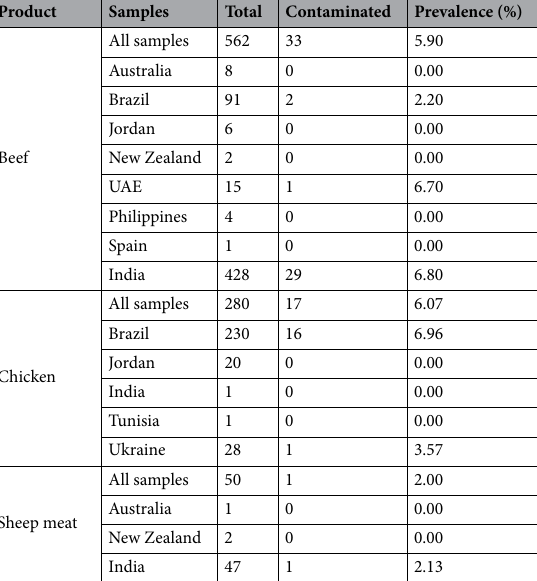
Table 1. Prevalence of Escherichia coli O157:H7 (as inspected by the Saudi Food and Drug Authority) in imported beef, chicken and sheep meat samples in Saudi Arabia in 2017.